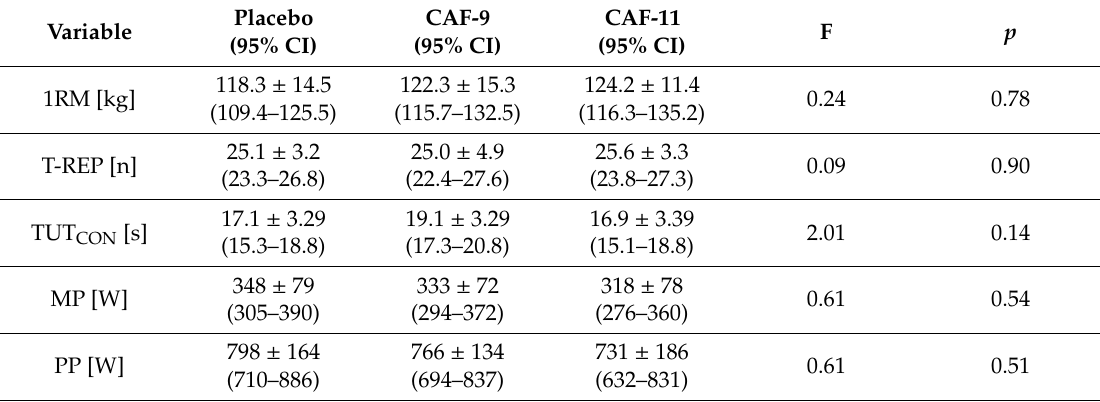
Table 1. Summary of performance data under the three employed